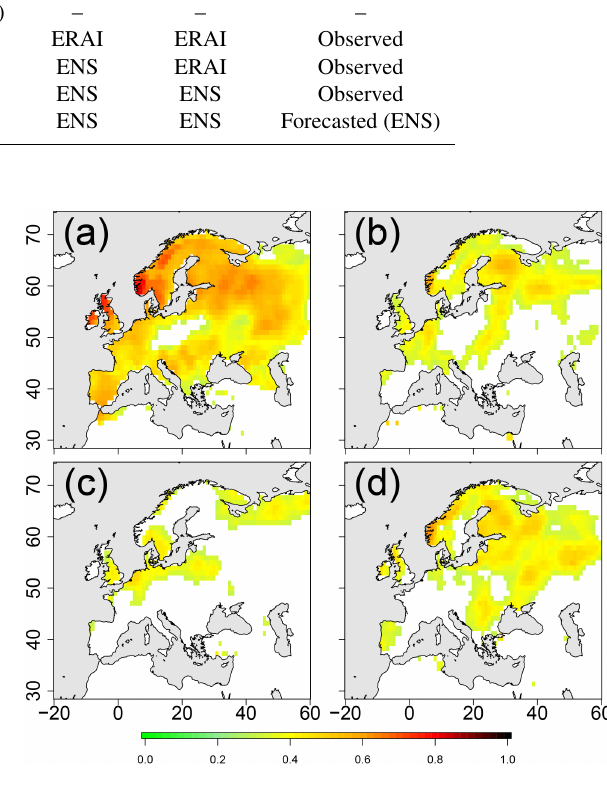
Figure 2. Absolute values of temporal correlation between SPI-1 and MOAWR derived from ERAI (used for the operational and ide- alized forecasts) attributed from the 16 combinations in winter (a) , spring (b) , summer (c) and autumn (d) . Only values with a confi- dence level larger than 90% are